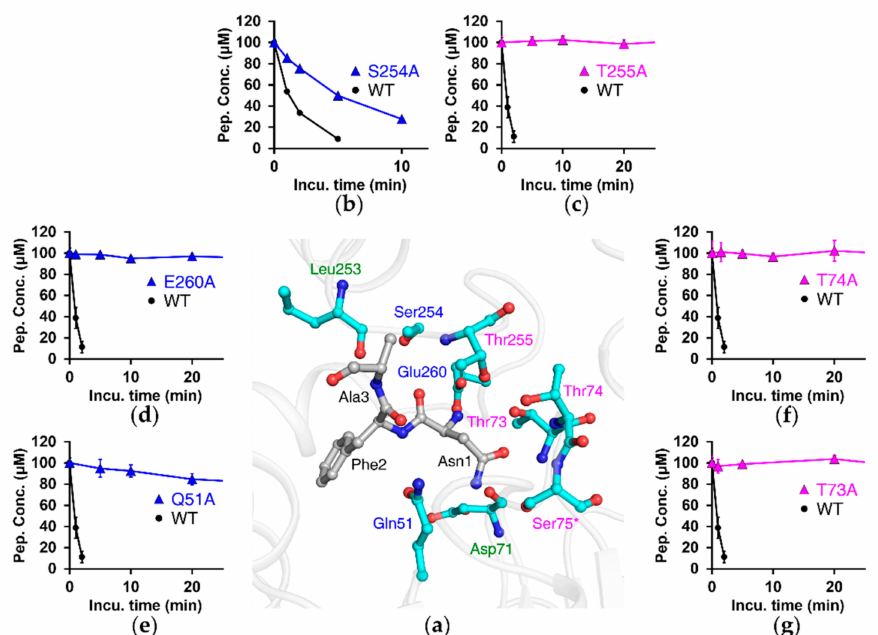
Figure 3. Residues interacting with substrate peptide through hydrogen bonds or salt bridges are crucial in catalytic activity of NTAN1. ( a ) Structure of NTAN1 C75S mutant in complex with the NFAAR pentapeptide at the active site. NTAN1 residues interacting with the peptide through hydrogen bonds or salt bridges are shown in cyan ball-and-stick model (Ser75 mutated from catalytic Cys75 is labeled with an asterisk). Thr73, Thr74, and Thr255 interact with the peptide via both their side chains and backbones, and are labeled in magenta. Gln51, Ser254, and Glu260 interact with the peptide via only side chains, and are labeled in blue. Asp71 and Leu253 interact with the peptide via only backbones, and are labeled in green. The bound peptide is colored in gray. Nitrogen and oxygen atoms are colored in blue and red, respectively. ( b – g ) Deamidation activities by Ala-mutants of NTAN1 residues described in ( a ). Concentrations of the NRAAA peptide are plotted against incubation times with NTAN1 WT and mutants, S254A ( b ), T255A ( c ), E260A ( d ), Q51A ( e ), T74A ( f ), and T73A ( g ). Error bars indicate standard-deviation values of three independent